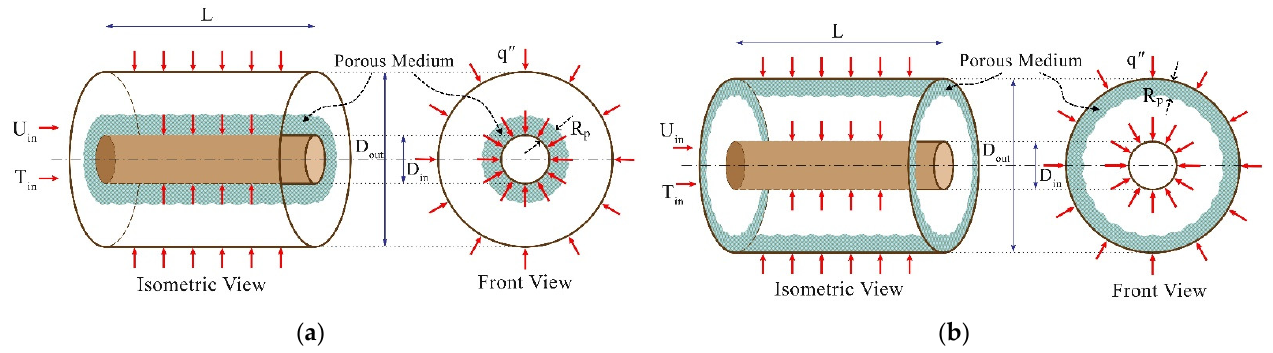
Figure 1. Schematic geometry of the problem. (𝐚) Case I , porous medium in the inner wall. (𝐛) Case II , porous medium in the outer wall. ( b ) Case II, porous medium in the outer wall.